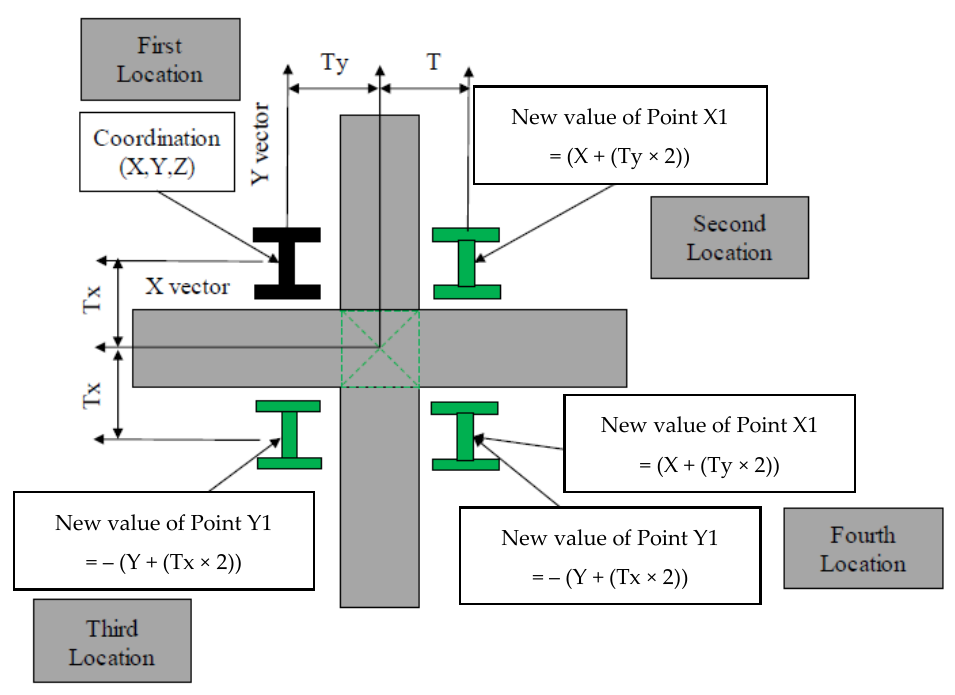
Table 5. A brief description of each software. Figure 13. Three options of kingpost relocation.